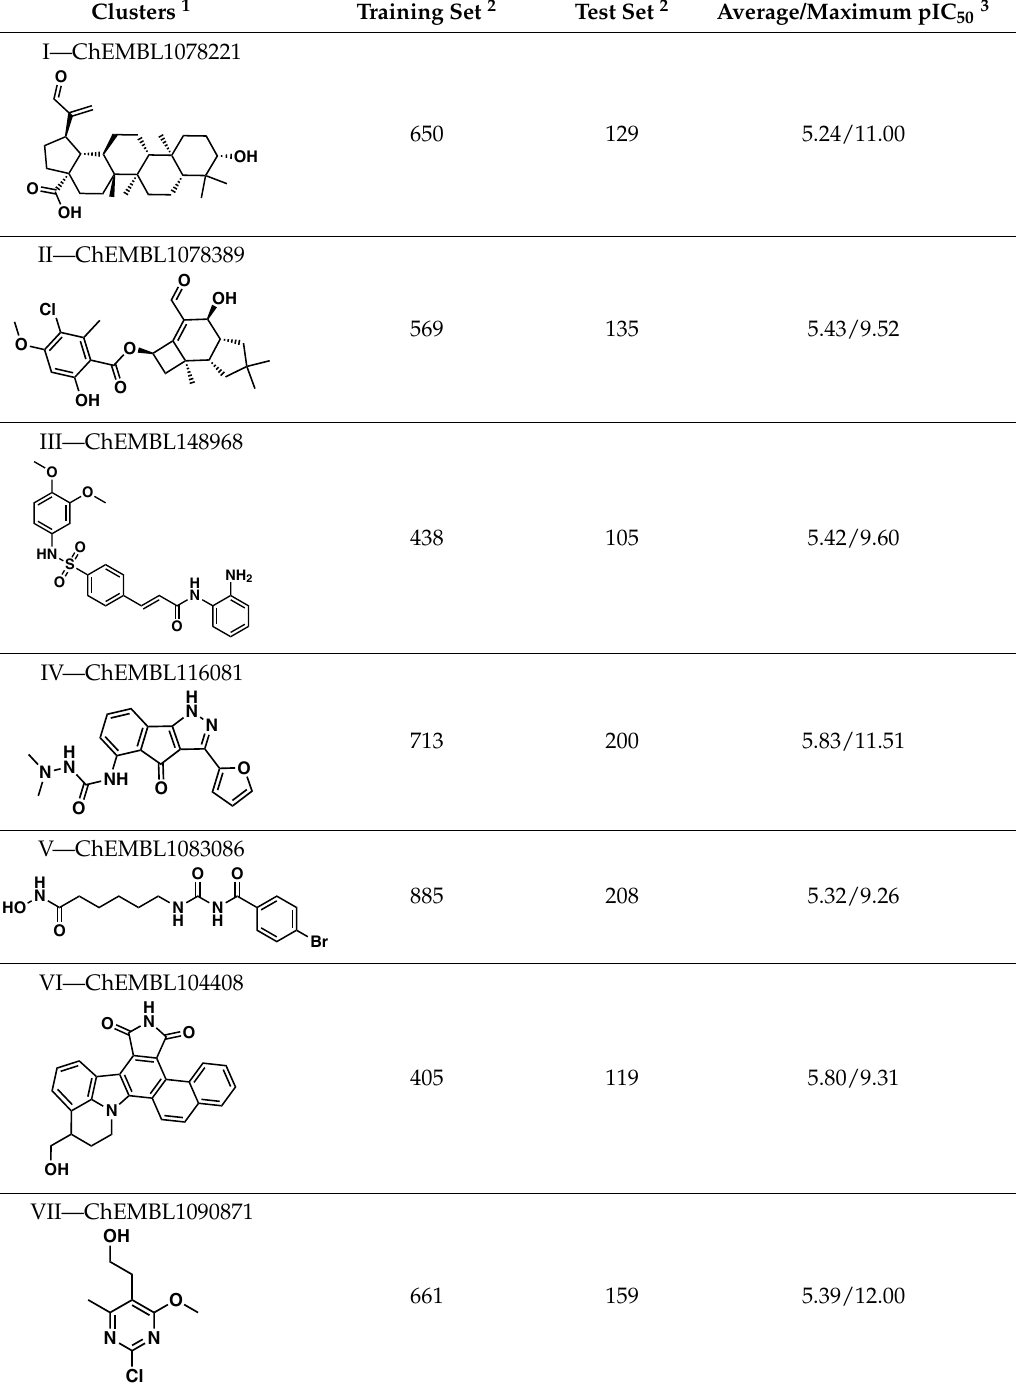
Table 1. Structural Clusters and pIC 50 Values for HCT116 within the Clusters. Clusters 1